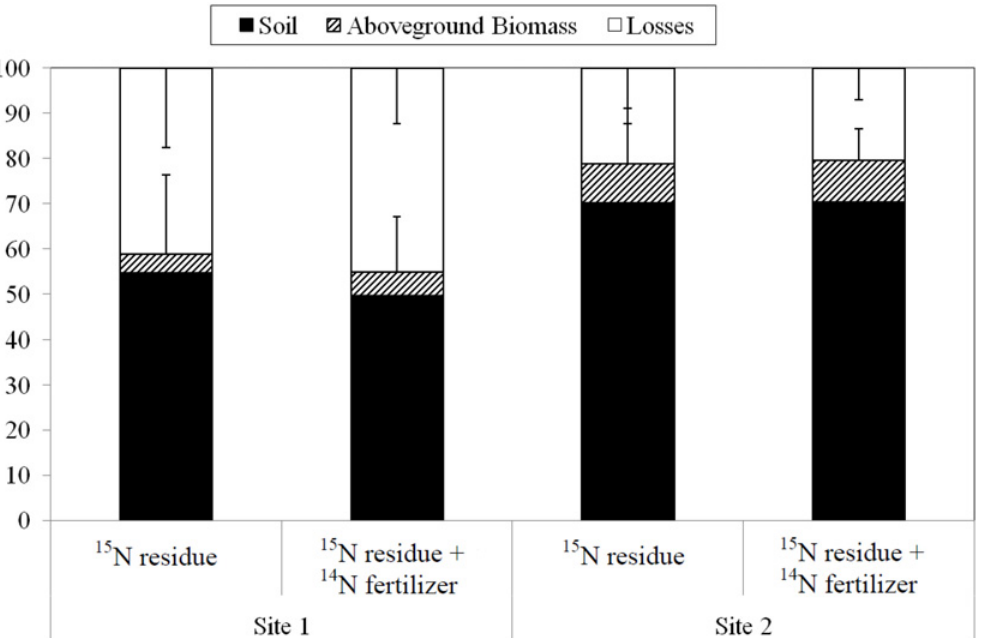
Fig 2. The fate of 15 N from labeled rice residue at harvest from two treatments: addition of 15 N-labeled residue without fertilizer ( 15 N-residue), and addition of 15 N-labeled residue with 80 kg N ha -1 14 N-urea ( 15 N-residue + 14 N-fertilizer). Error bars are the standard error of the mean losses or total recovery (n =